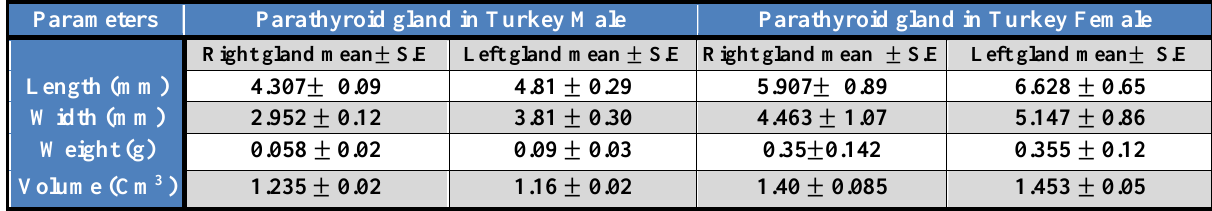
Table, 2: Dimensions of Parathyroid gland the Male and Female of local breed Turkey Meleagris gallopavo .